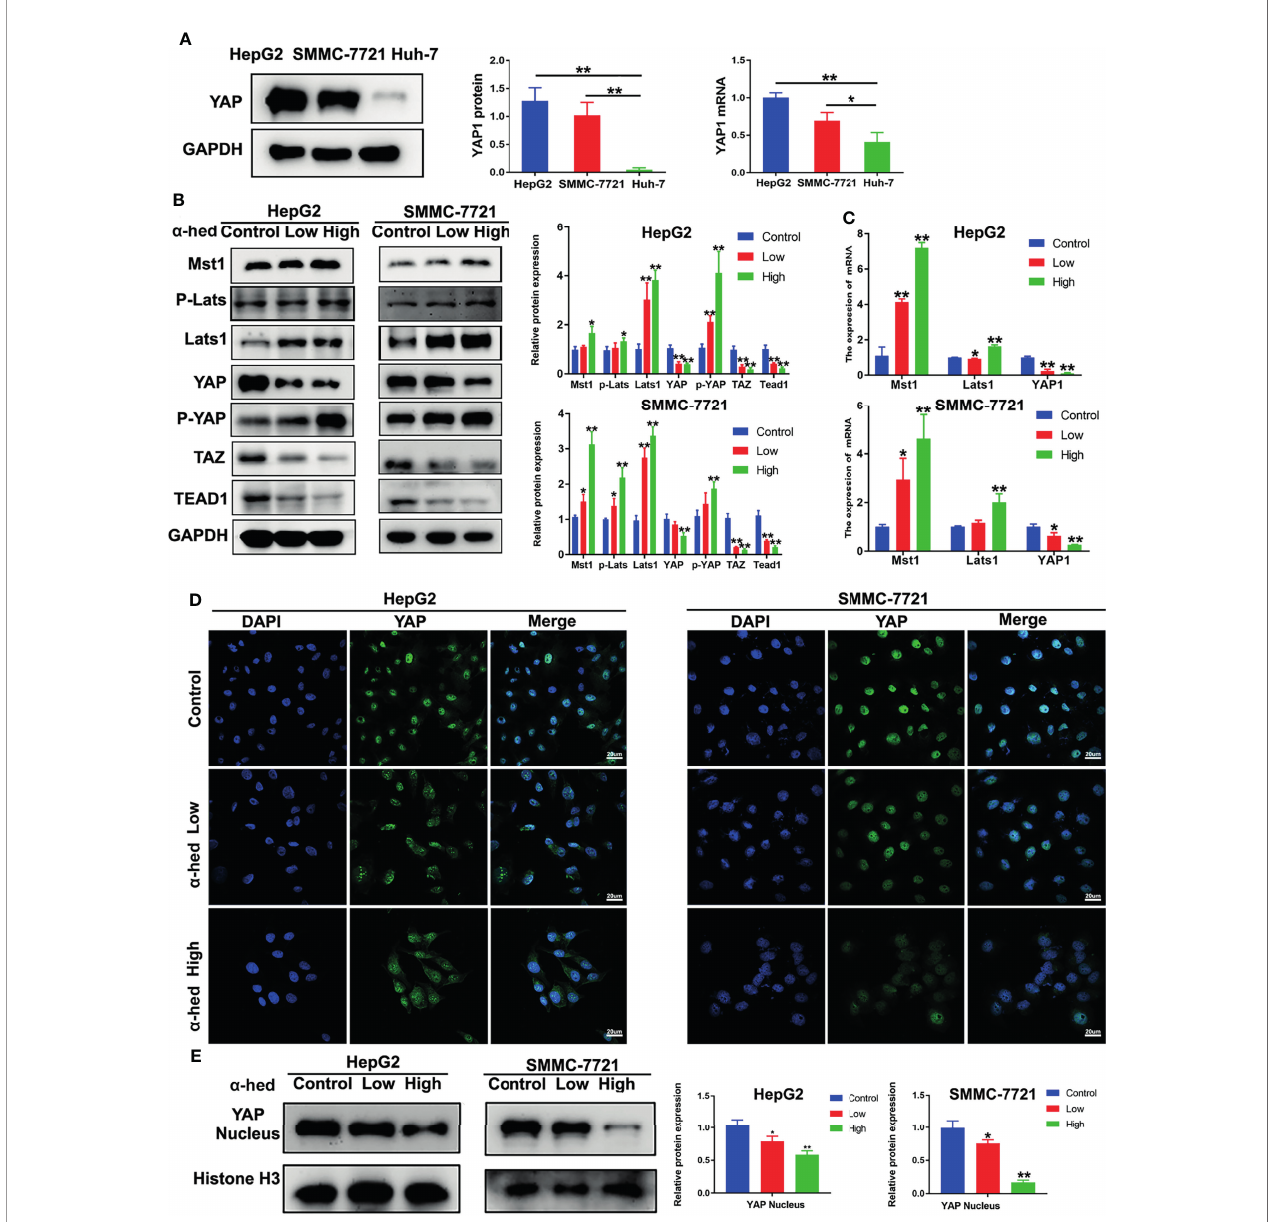
FIGURE 3 | a -hederin inhibited YAP activation via upregulating the activation of Hippo signaling pathway. (A) The protein and mRNA and levels of YAP in HepG2, SMMC-7721, Huh-7 cells. (B) HepG2 and SMMC-7721 cells were treated with a -hederin at low (10 µM) or high (20 µM) concentration for 24 h, and then the proteins involved in Hippo-YAP signaling pathway were analyzed by Western blot, followed by densitometric quanti fi cation. (C) The mRNA levels of Mst1, Lats1, YAP in HepG2 and SMMC-7721 cells treated with a -hederin for 24 hours were measured by RT-qPCR. (D) Immuno fl uorescence analysis of YAP in HepG2 and SMMC- 7721 cells. (E) The nuclear levels of YAP in HepG2 and SMMC-7721 cells treated with a -hederin at low (10 µM) or high (20 µM) were analyzed by Western blot. Signi fi cance: * p < 0.05 versus control, ** p < 0.01 versus